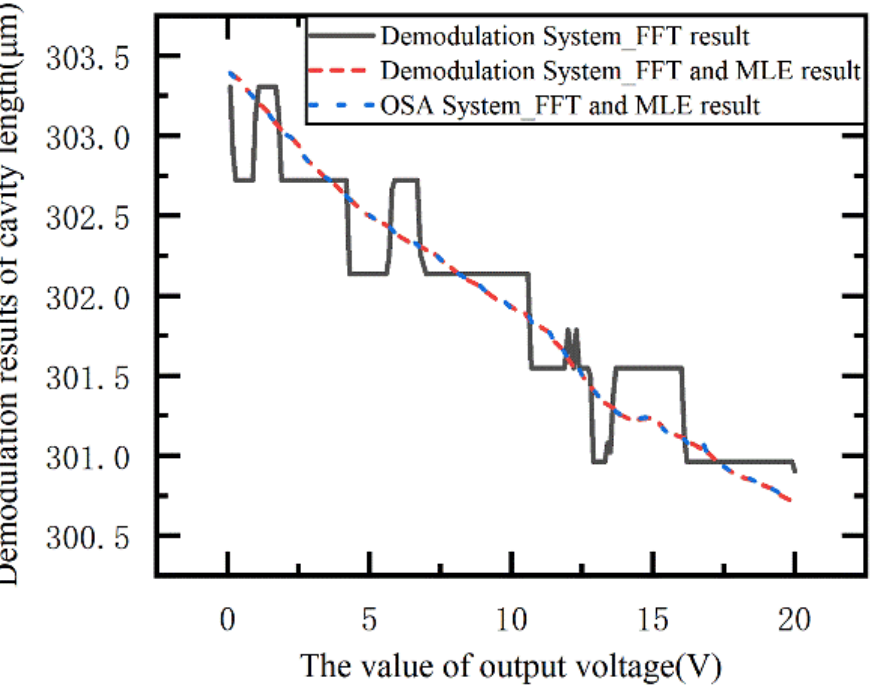
Figure 12. The demodulation results between OSA and the demodulation system.